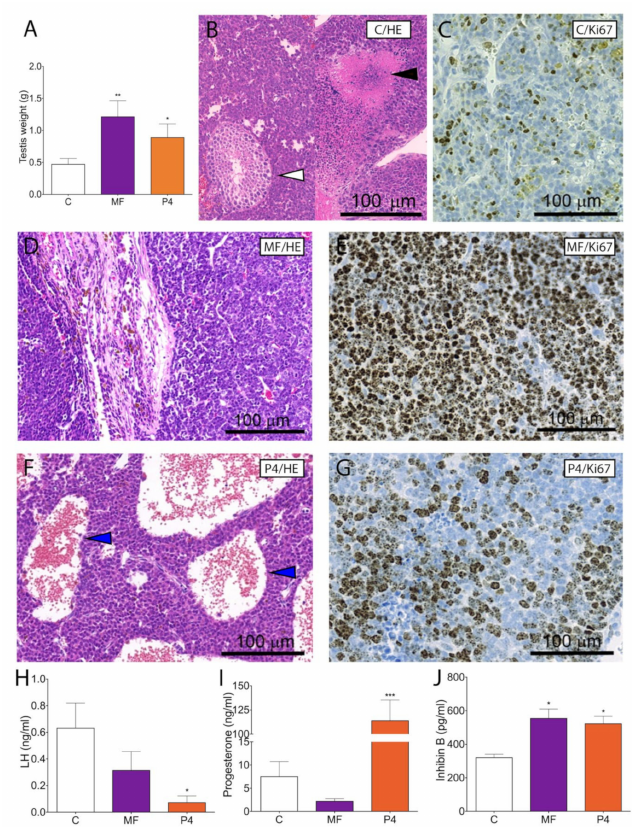
Figure 2. Treatment of Inh α / Tag TG mice presenting Leydig cell tumors and post-treatment hormonal values. Total testicular tumor weights (mean ± SEM) of control, MF-treated and P4-treated Inh α / Tag TG mice ( A ). Analyses of the control histopathology ( B ), control Ki-67 staining ( C ) MF-treated histopathology ( D ), MF-treated Ki-67 staining ( E ) P4-treated histopathology ( F ) and P4-treated Ki-67 staining ( G ) Inh α / Tag TG mice. Serum concentrations (mean ± SEM) of LH ( H ), P4( I ), and inhibin B ( J ) of the non-treated (vehicle) (control), MF-treated and P4-treated Inh α / Tag TG mice. White arrow heads indicate tubular structure ( B ), black arrow heads necrotic area ( B ), blue arrow heads blood-filled cavities ( F ). Asterisks indicate significant di ff erences between non-treated and treated groups (*, p < 0.05; **, p < 0.01; ***, p < 0.001). Scale bar, 100 µ m. C, control; Inh α / Tag TG mice; transgenic mice